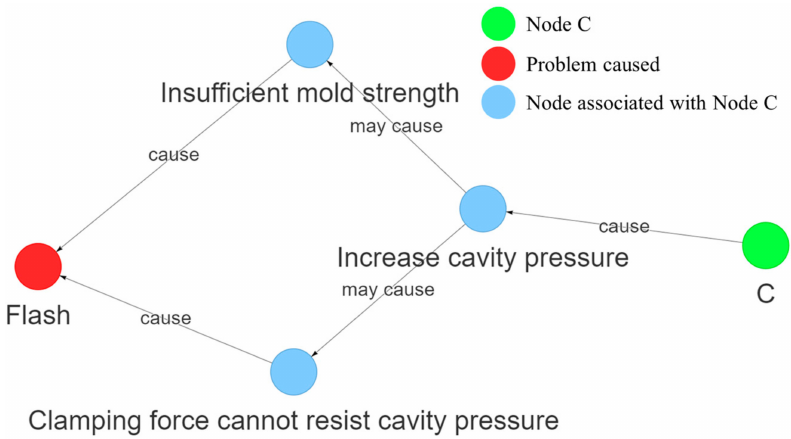
Figure 18. Search result of case